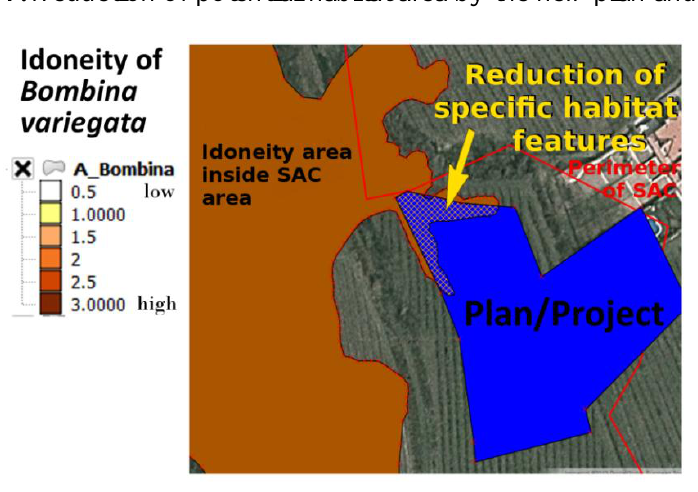
Figure 11. Reduction of potential habitat area by the new plan and